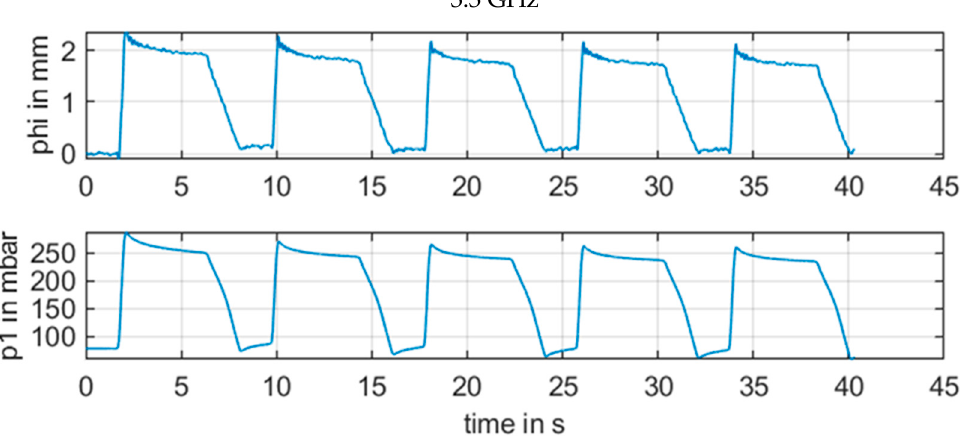
Figure 11. Measurement results for φ m [ mm ] of CW radar with frequency of 3.3 GHz in comparison with reference pressure p1 from pressure sensor.